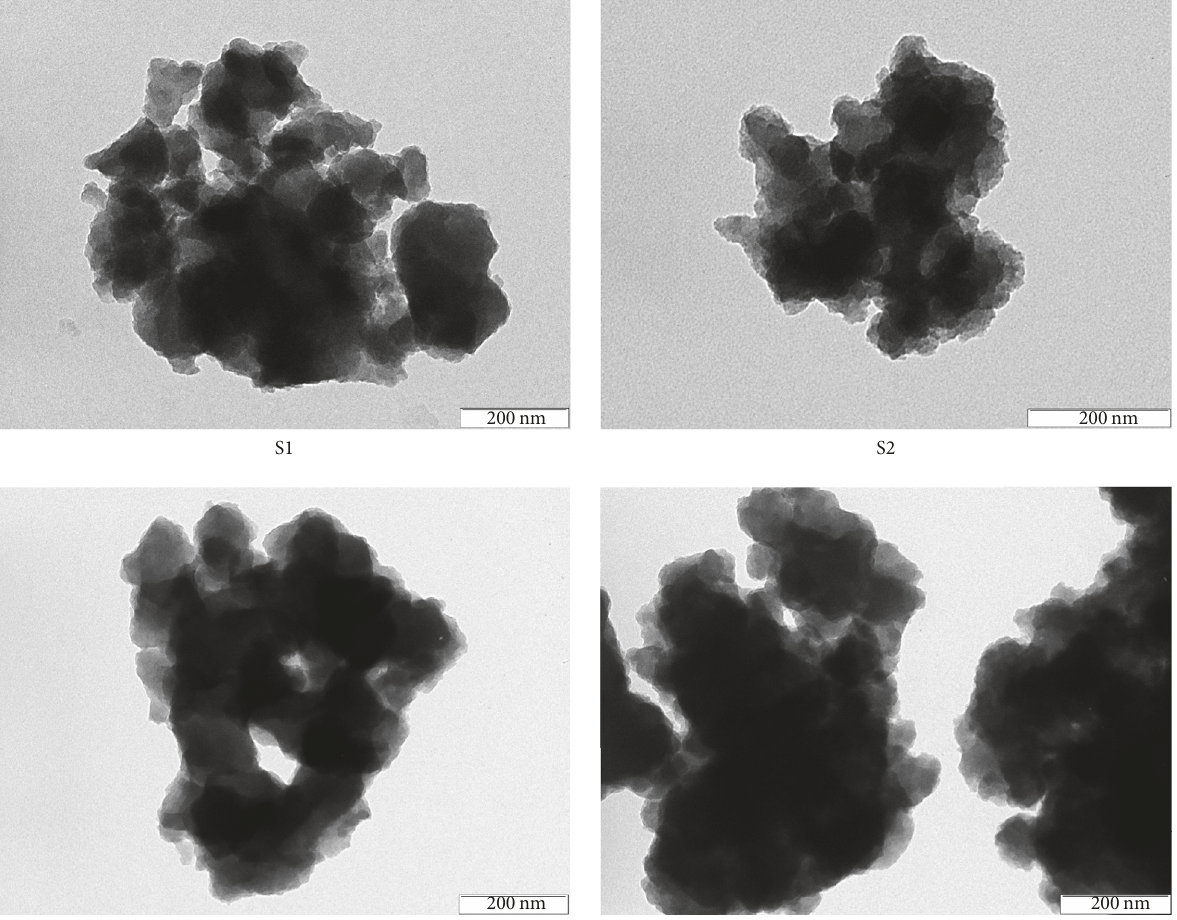
Figure 5: TEM images for S1, S2, S3, and S8 materials.